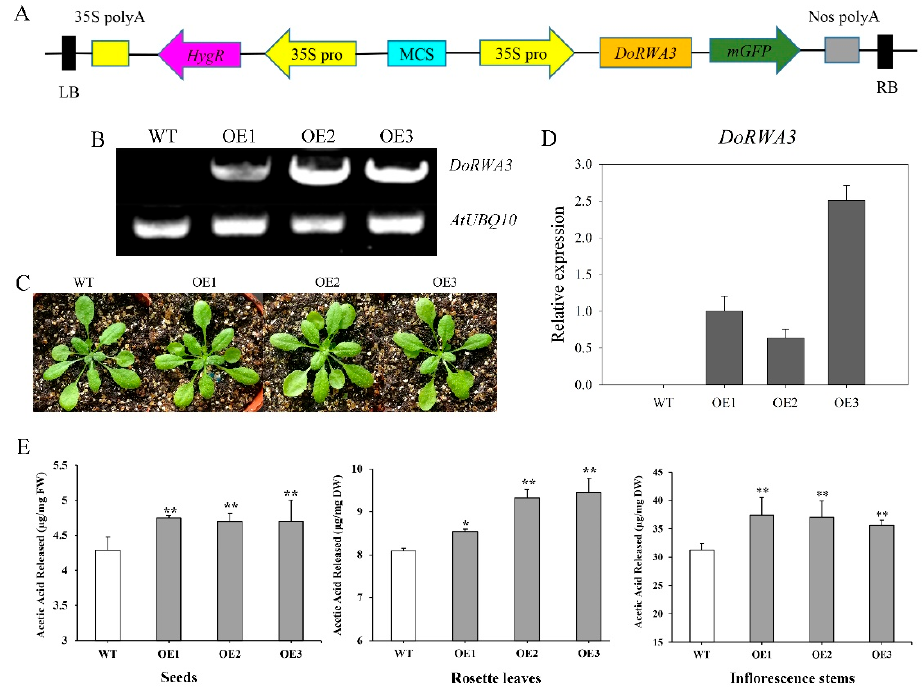
Figure 8. Overexpression of DoRWA3 increased the acetylation level of polysaccharides in A. thaliana . ( A ) The pCAMBIA1302 vector used for A. thaliana transformation. ( B) Semi–quantitative PCR of the DoRWA3 gene in wild type (WT) and three overexpression (OE) transgenic ( 35S::DoRWA3 ) lines: OE1, OE2 and OE3. ( C ) Phenotype of the WT and three OE transgenic lines. ( D ) qRT-PCR analysis of DoRWA3 in the WT and three OE transgenic lines. ( E ) The content of released acetic acid in different organs of the WT and three OE transgenic lines. The transcript level of DoRWA3 in OE1 was set as 1. FW, fresh weight; DW, dry weight. Data bars represent the mean ± SD ( n = 3). * and ** indicate p < 0.05 and p < 0.01 between the WT and OE transgenic lines according to DMRT.